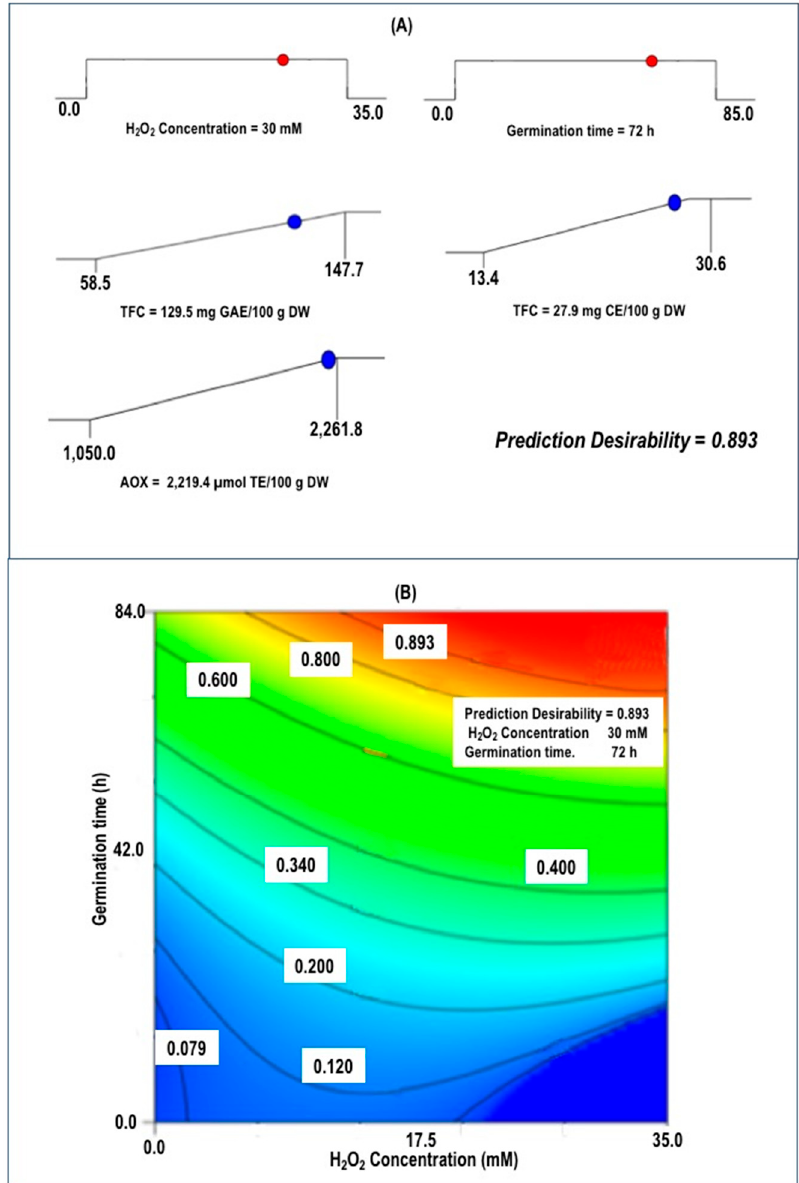
Figure 3. Desirability analysis. ( A ) Plots ramp showing the optimal experimental parameters ((H 2 O 2 ) and Gt) that maximize TPC, TFC, and AOX, ( B ) Contour plot of overall desirability showing the best combination of germination condition (H 2 O 2 concentration and germination time) for producing optimized chickpea sprouts.